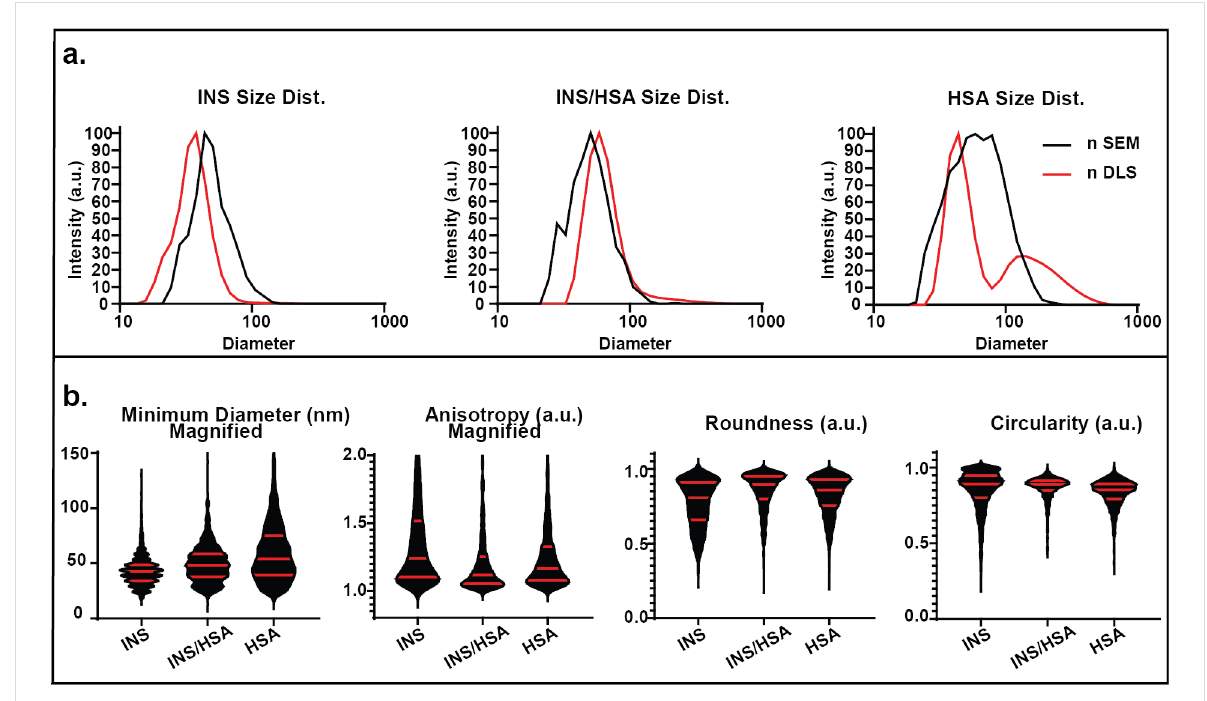
Figure 5: Size distribution and secondary geometric factors of INS SPNPs based on SEM and DLS analysis. (a) Number distributions of SPNP sizes as obtained by SEM and DLS. (b) Violin graphs of minimum diameter, anisotropy, circularity and roundness (median and interquartile ranges are presented by red